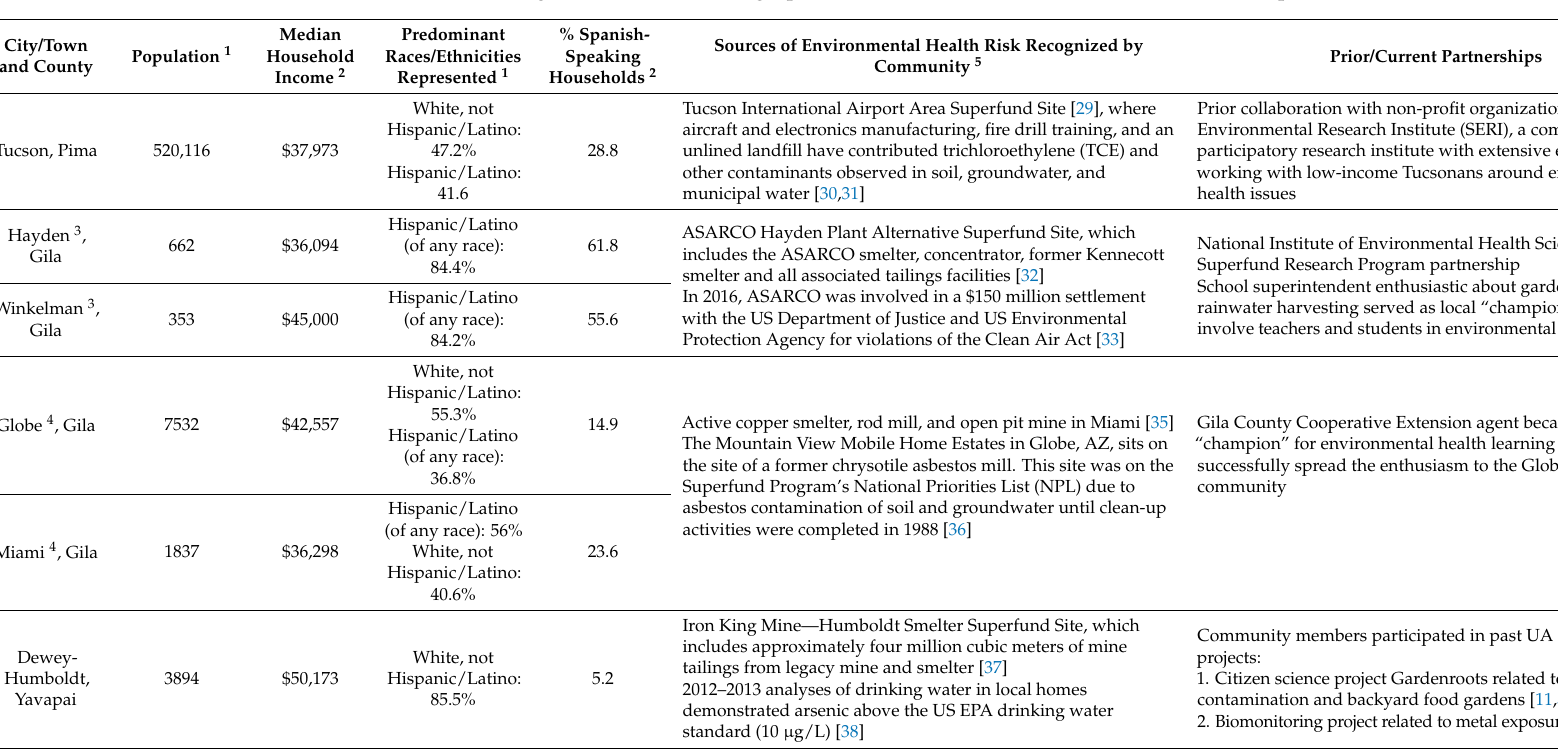
Table 1. Partnering Communities Demographics, Environmental Health Risk, and